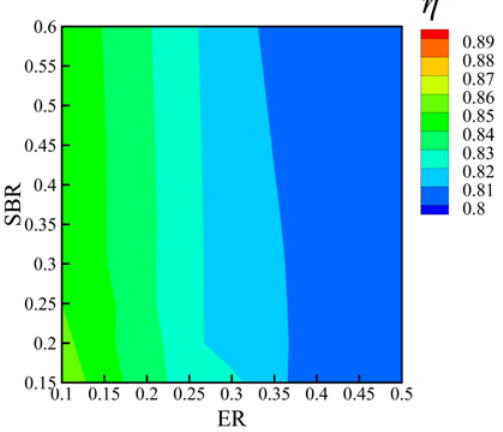
Figure 25. Exergy efficiency distribution at T = 1100 K.